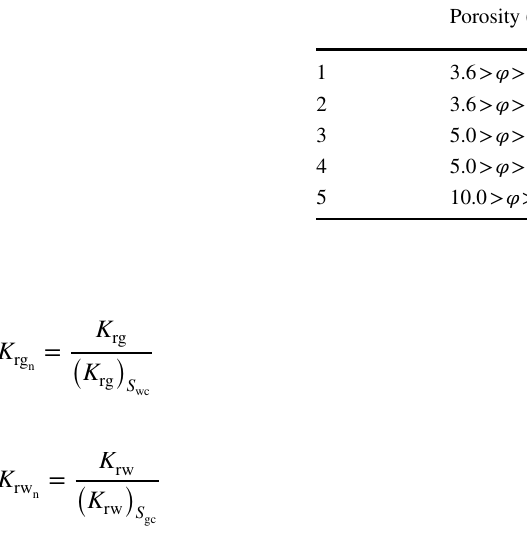
Table 1 Petrophysical characteristics of the reservoir